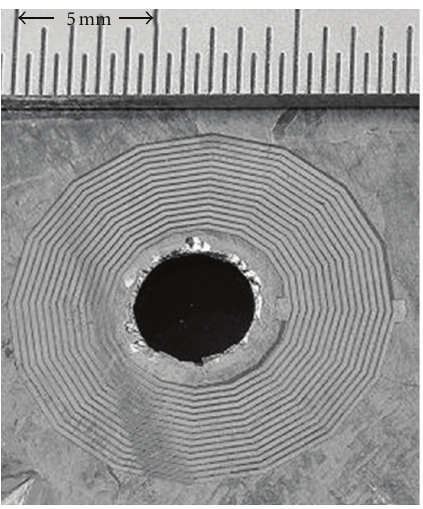
Figure 6: Overhead view of triple-layer inductor with air core.